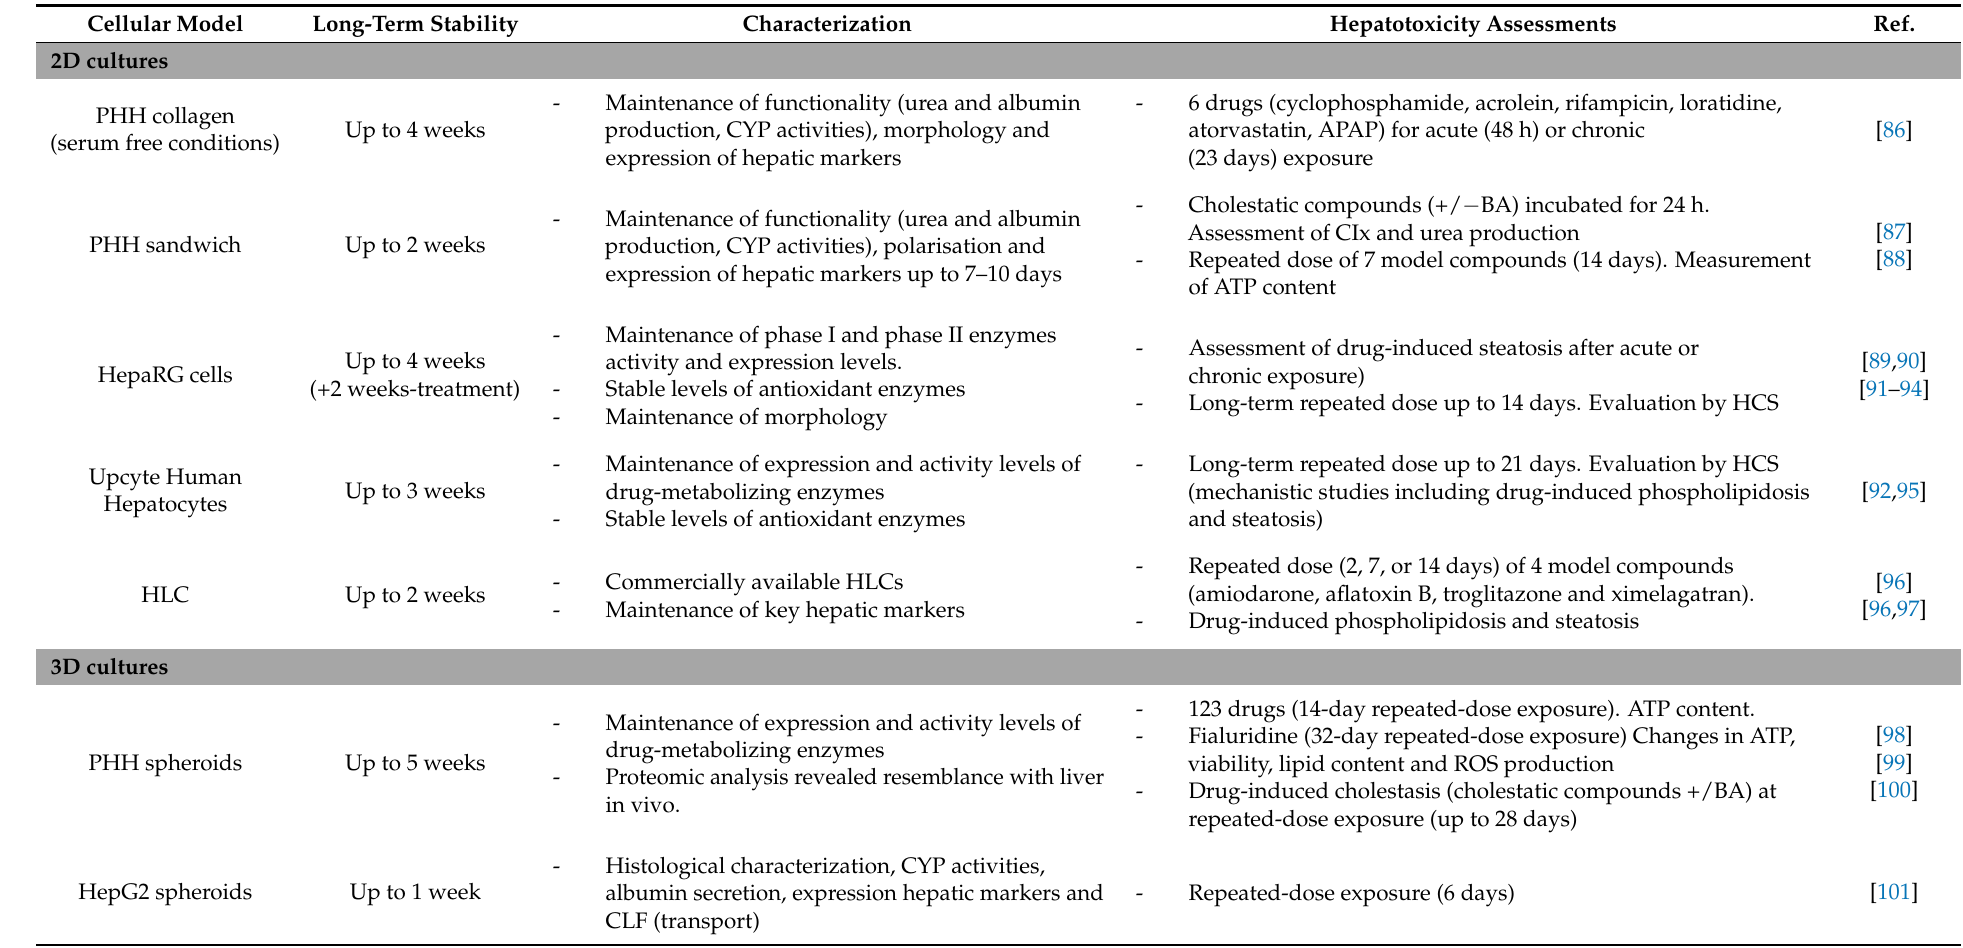
Table 2. Cellular models for studying chronic